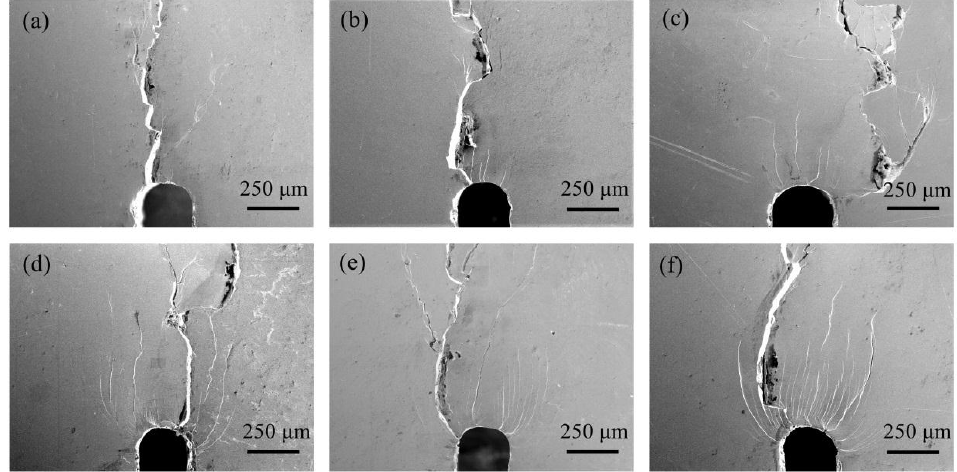
Figure 6. SEM images of the lateral surface of the MG samples after fracture at different temperatures.